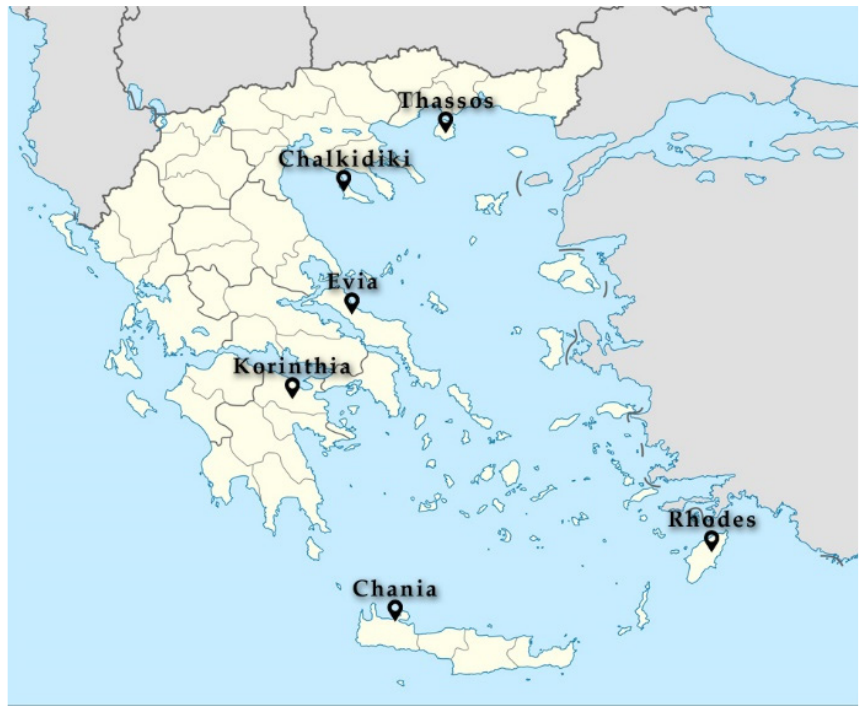
Figure 1. Locations of collected pine honey samples across Greece.